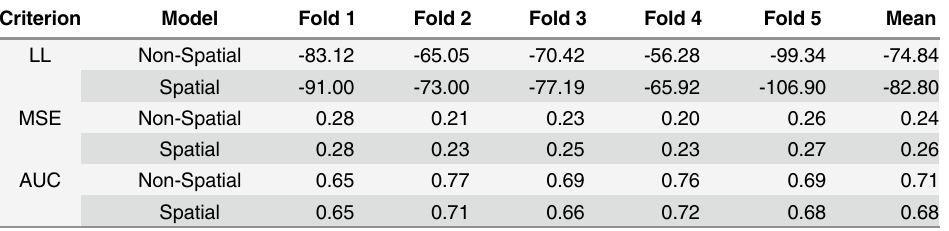
Table 3. Posterior mean out-of-sample Log likelihood (LL), Mean Squared Errors (MSE) and Area Under the Curve (AUC) for the k-fold cross validation based on fitted parameter estimates under the Spatial and Non-Spatial Models. Lower estimates of LL and MSE correspond to better predictive perfor- mance by a model; higher estimates of AUC corresponds to better predictive performance.